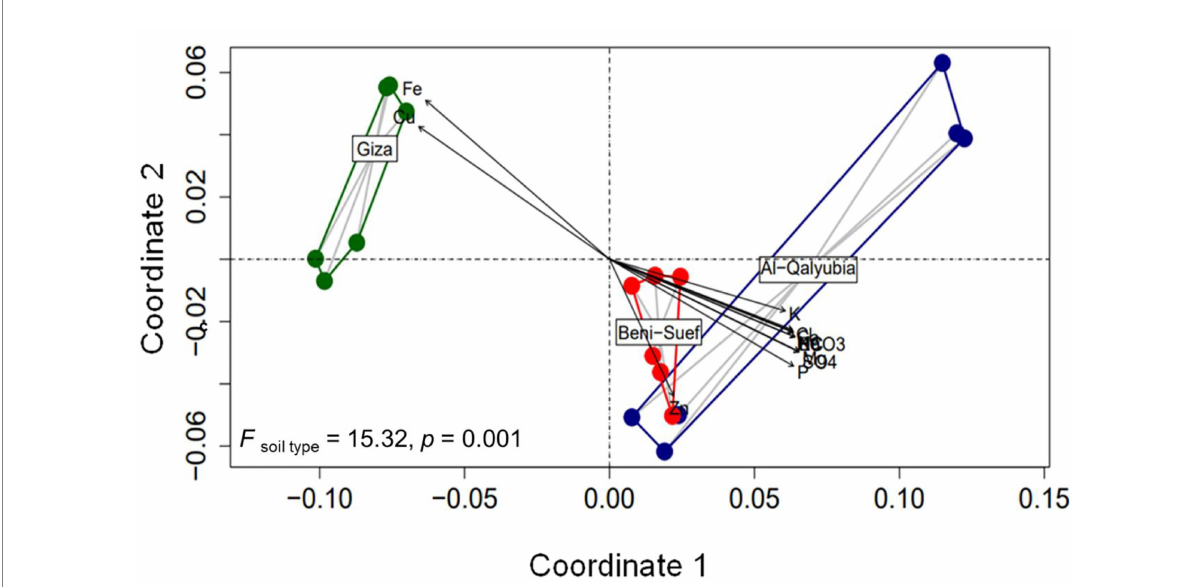
FIGURE 6 Non-metric multidimensional scaling (NMDS) ordination diagram of wheat growth traits in soils from three locations [Al-Qalybia (Q), Beni-Suef (B), and Giza (G)]. The NMDS ordination was fitted with physiochemical soil parameters ( p < 0.05).